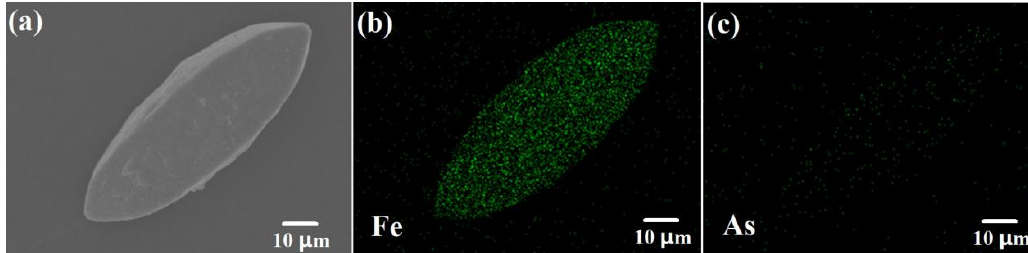
Figure 5. ( a ) Location SEM image; ( b ) Fe and ( c ) As image of energy-dispersive X-ray spectroscopy